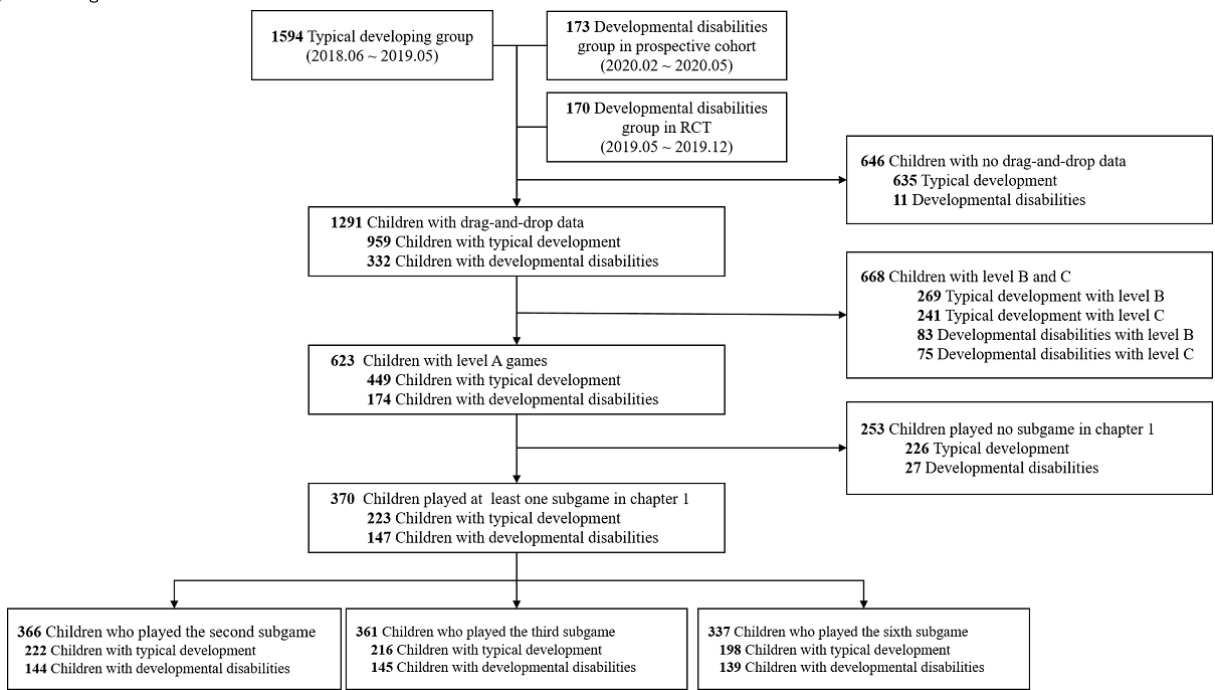
Figure 1. Eligible user selection